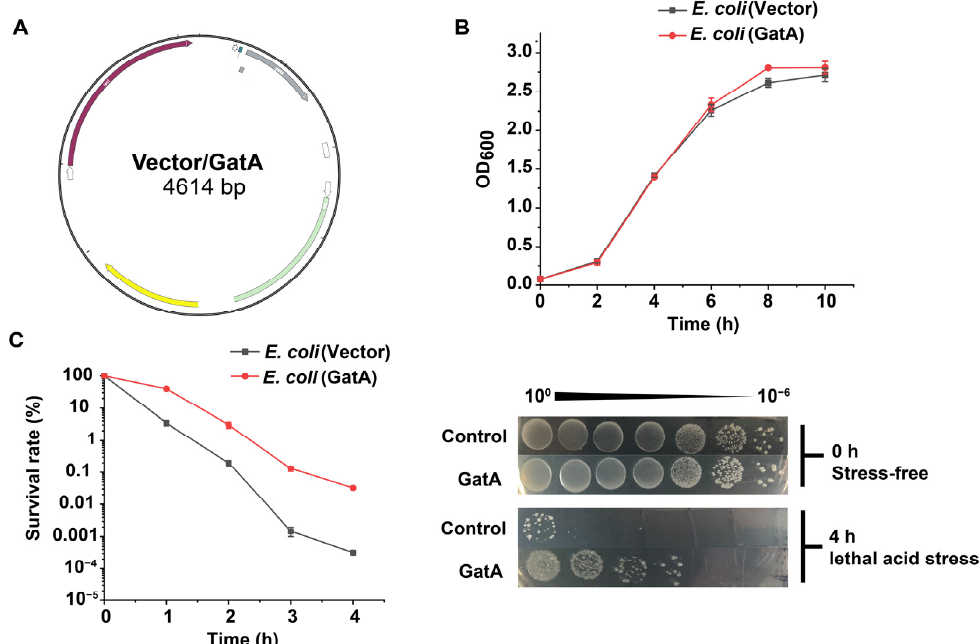
Figure 1. Construction and performance of recombinant strain E. coli (Vector) and E. coli (GatA). ( A ) The recombinant plasmid pTrc99a/GatA was constructed by inserting the galactitol transport factor gatA into plasmid pTrc99a. ( B ) Growth curve of recombinant strains in normal growth condition without acid stress. ( C ) Cell viability of recombinant strains under conditions of D-LA lethal stress. gatA encodes the small hydrophilic peptide GatA, which plays an important role in the transport and phosphorylation of the phosphotransferase system (PTS) [30]. PTS is dependent on phosphoenolpyruvate (PEP), which mainly phosphorylates various sugars and their derivatives and transports them intracellularly through a cascade of phosphorylation reactions [31]. Of the three cellular transport mechanisms, PTS belongs to the group translocation category, which means that substrates are metabolized simultaneously during transport [32]. Polypeptide chain GatA (EII A) and GatB (EII B) equipped with transmem- brane protein GatC (EII C), are a specific transporter protein complexes of galactitol [32]. Previously, GatC was shown to eliminate ATP limitation and replace the original ATP- dependent transporter protein to transport xylose [33]. As is well-known, ATP is used as an energy source by cells, and cells consume energy to maintain their growth and metabolism, while withstanding adverse factors in the extracellular environment. Therefore, we hypoth- esized that the anti-acid factor GatA enhances cell survival under conditions of organic acid stress, with the beneficial effects due to a globalized ATP repletion mechanism (Figure